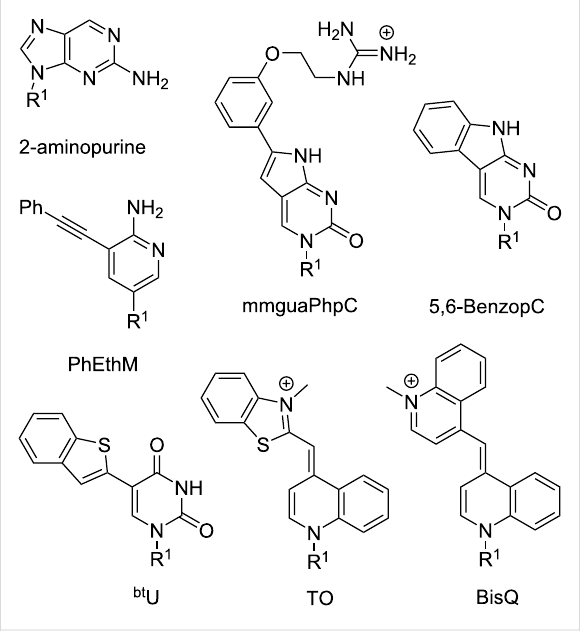
Figure 10: Examples of fluorescent PNA nucleobases. R 1 denotes DNA, RNA, or PNA backbones.